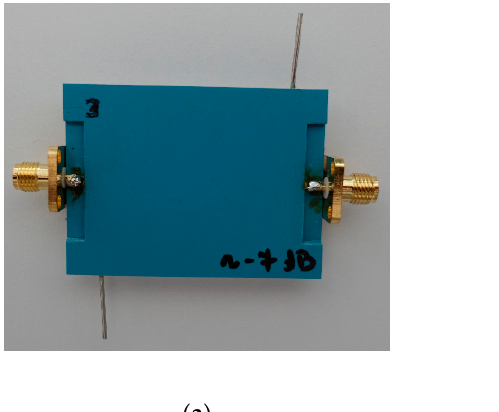
Figure 5. The LTCC layers for the resonator-based sensor: ( a ) bottom layer with deposited ground plane, ( b ) bottom layer, ( c ) layer with cuts for fluidic ports, ( d ) layer with microfluidic channels, ( e ) layer with deposited two-gap ring resonator, ( f ) layer with microchannel and microstrip terminal, ( g ) top layer with cuts for fluidic port, ( h ) top layer with cuts for microstrip terminals.